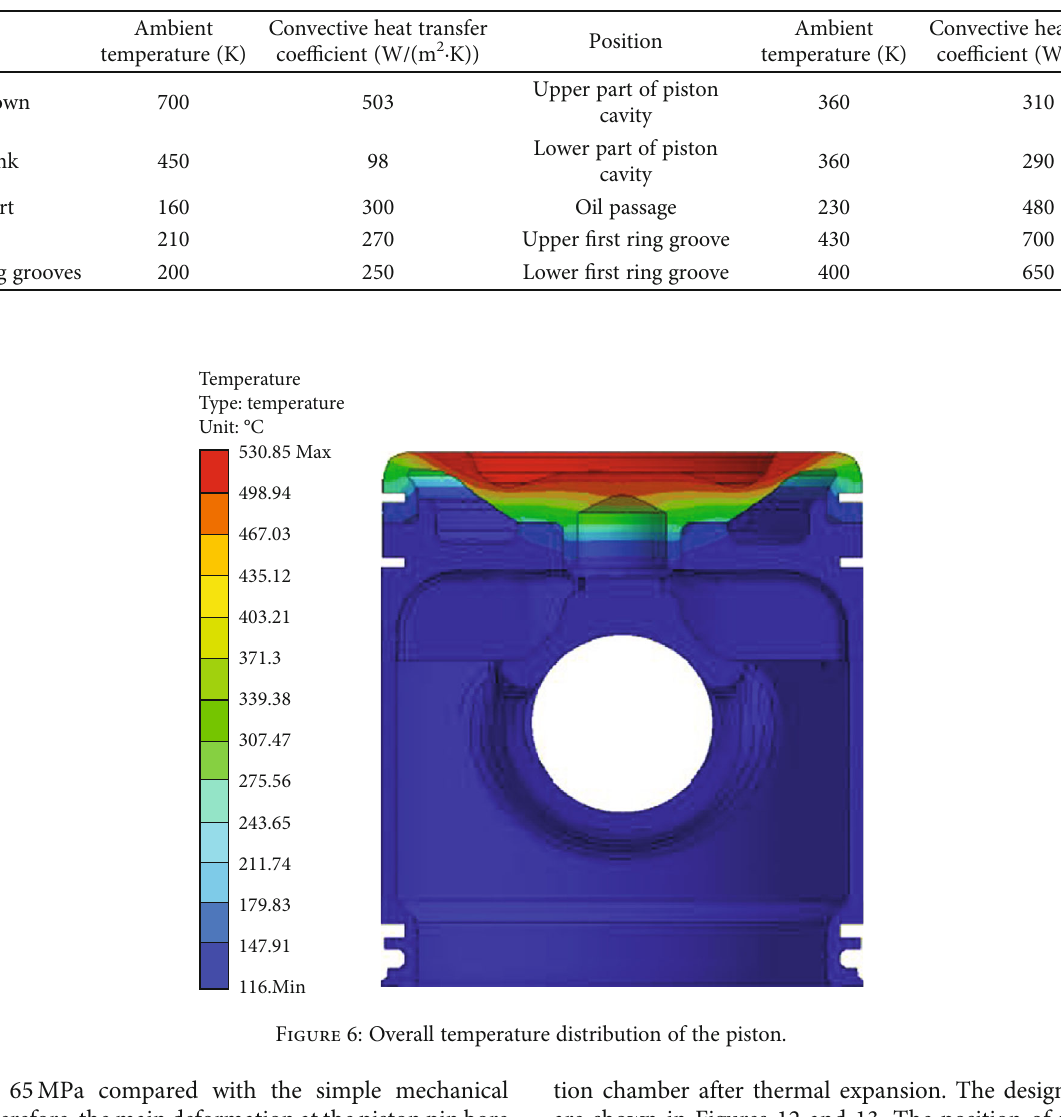
Table 3: The third kind of thermal boundary condition of the piston of an aircraft engine.